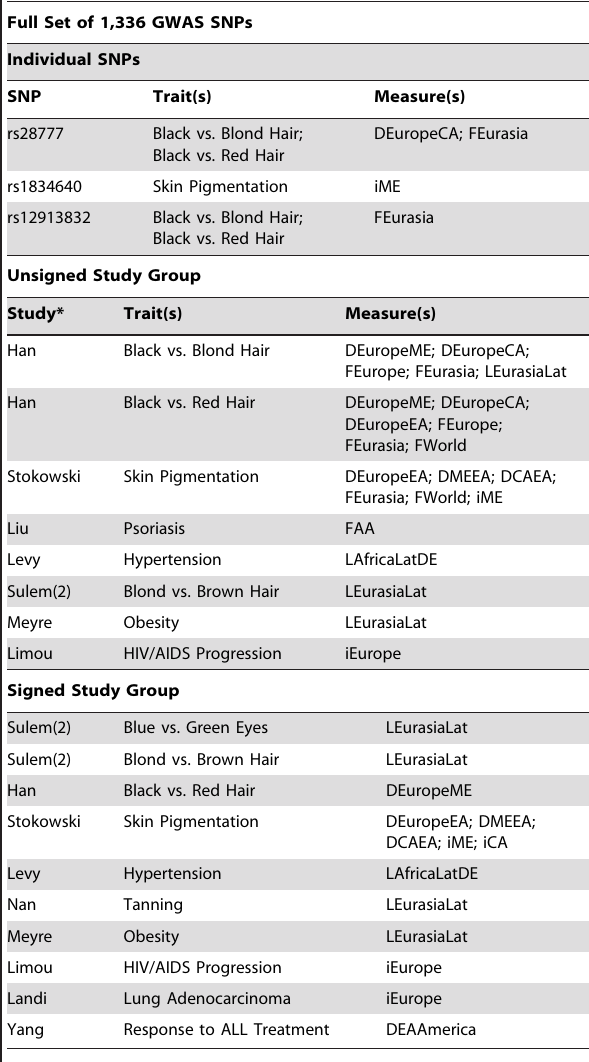
low p-values for more delta, F st , LLC, and iHS measures than did the other trait classes in the individual SNP and unsigned group analyses. In one departure from previous observations, blood pressure study groups also produced low p-values for a number of measures in the signed group analysis. Additionally, we noted that in the II unsigned group analysis, study groups of the